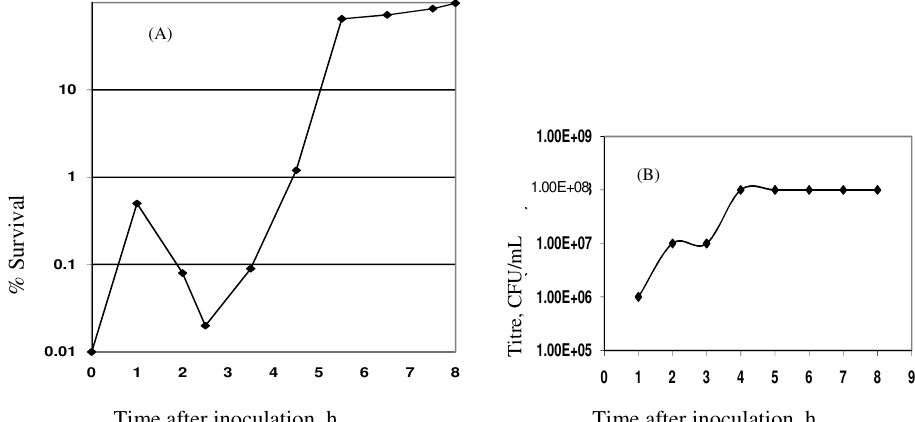
Figure 2. Growth cycle and sensitivity to oxidative stress of L. monocytogenes (A) Culture titre, (B) Percent survival of cells after a 10 min treatment with 100 µ M H